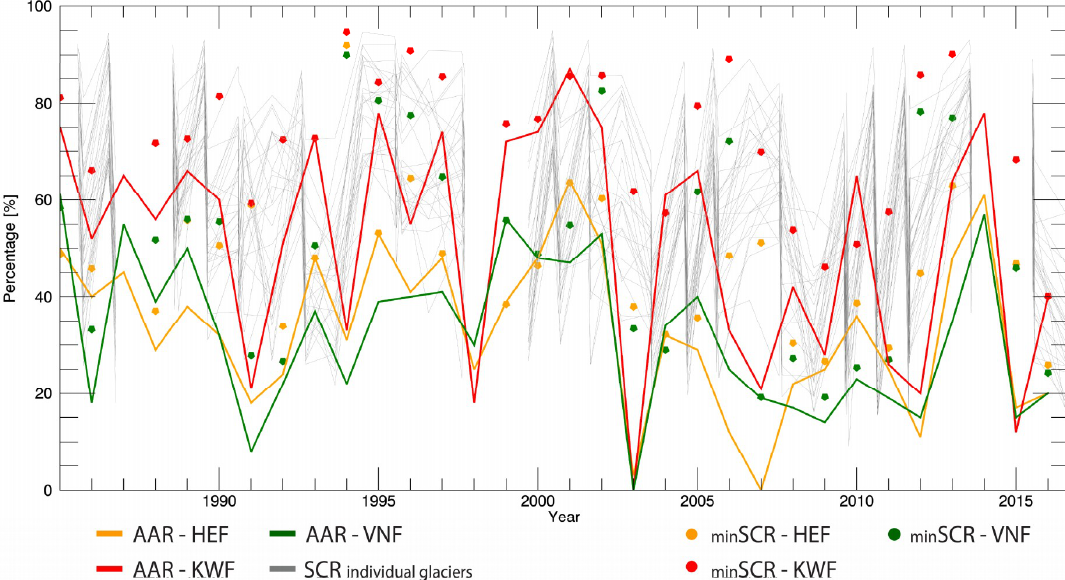
Figure 6. Snow cover ratio (SCR) for all glaciers (grey lines connecting one SCR value with the following one) within the >30 years study period. Colored points mark the minimum SCR for HEF, KWF and VNF for the respective season. The accumulation area ratio (AAR) values derived in the field for the three glaciers are shown as lines.